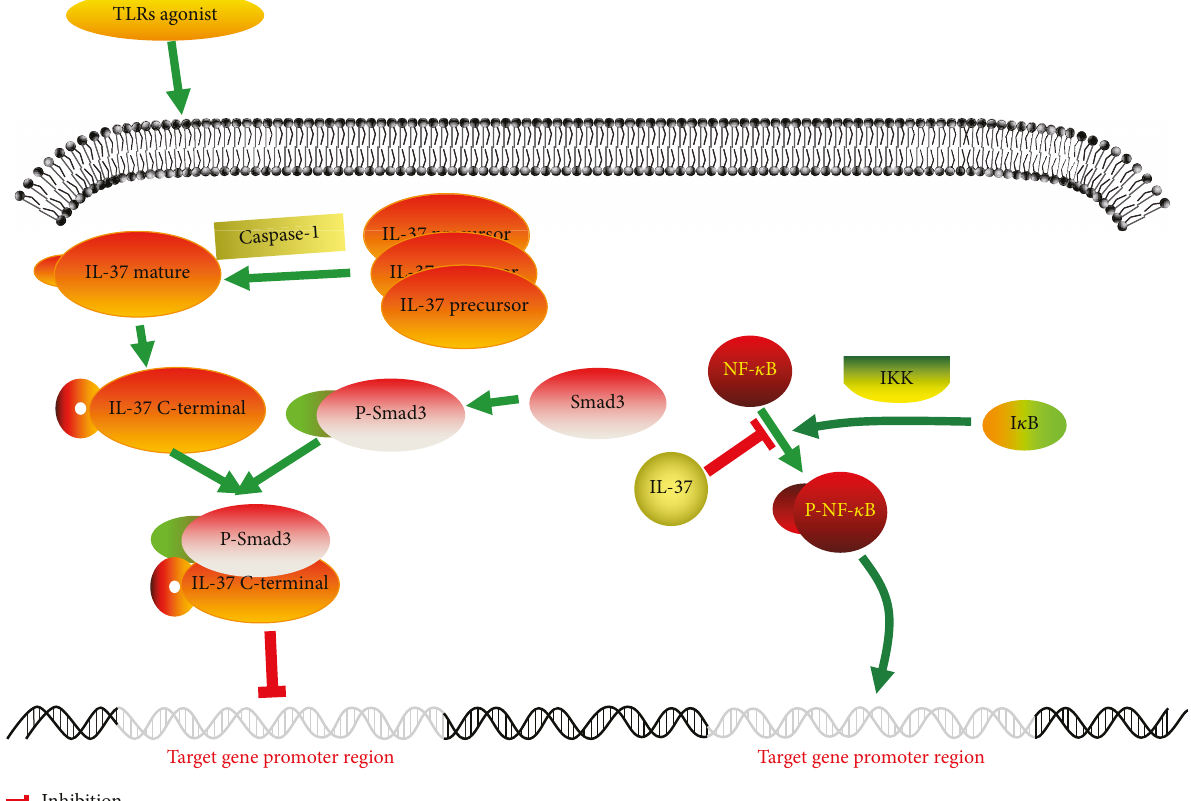
Figure 1: IL-37 is a “ dual function ” anti-in fl ammation cytokine. IL-37 exerts anti-in fl ammatory responses beginning with the nuclear activity intracellularly. IL-37 can recruit Smad3 in the cytoplasm and then comes into being a complex of Smad3 and IL-37, which induces the nuclear activity of IL-37. Then the complex translocates into the nucleus to suppress TLR-induced proin fl ammatory cytokine. Meanwhile, NF- κ B may be phosphorylated by IKK in the cytoplasm and then exposures to the nuclear to regulate the transcription of proin fl ammatory cytokine, such as ICAM-1, VCAM-1, MCP-1, TNF- α , and IL-6. But the phosphorylation of NF- κ B can be inhibited by IL-37, which in turn decreases the production of proin fl ammatory